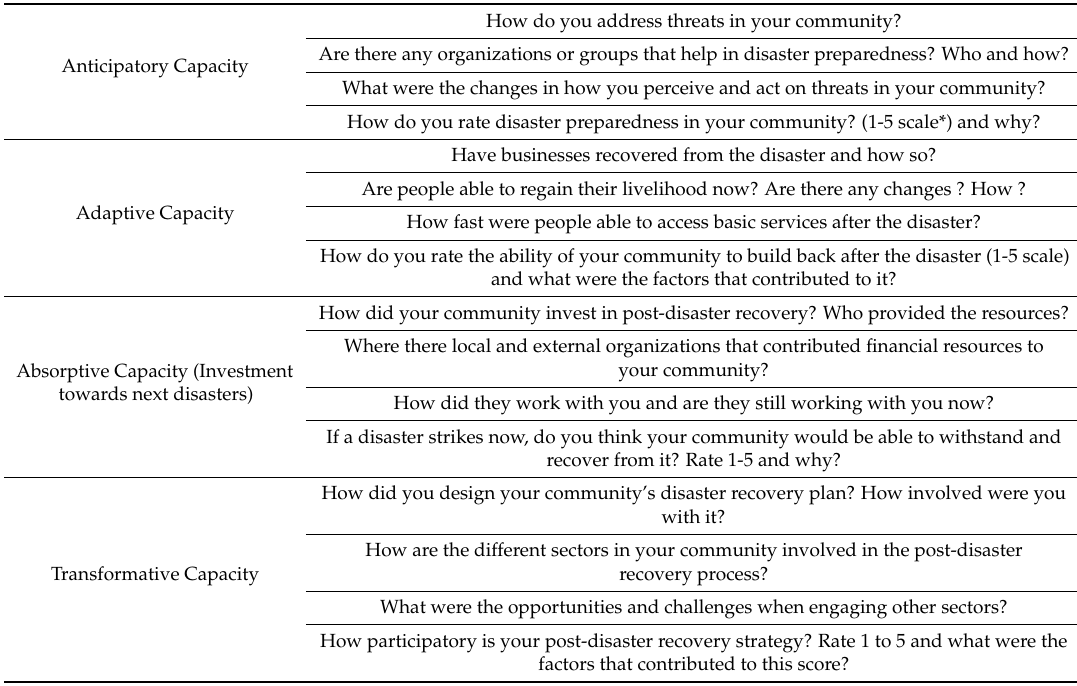
Table 3. List of the questions asked during the key informant